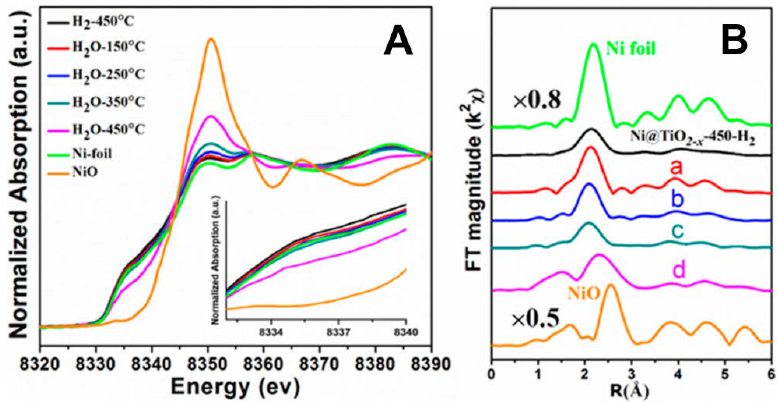
Figure 9. ( A ) Normalized Ni K-edge XANES spectra and ( B ) Fourier-transform Ni K-edge EXAFS spectra for Ni@TiO 2 − x (450) catalyst in H 2 O atmosphere at 150, 250, 350, and 450 ◦ C, respectively. Ni foil and NiO reference sample: Room temperature. Reprinted with permission from Reference